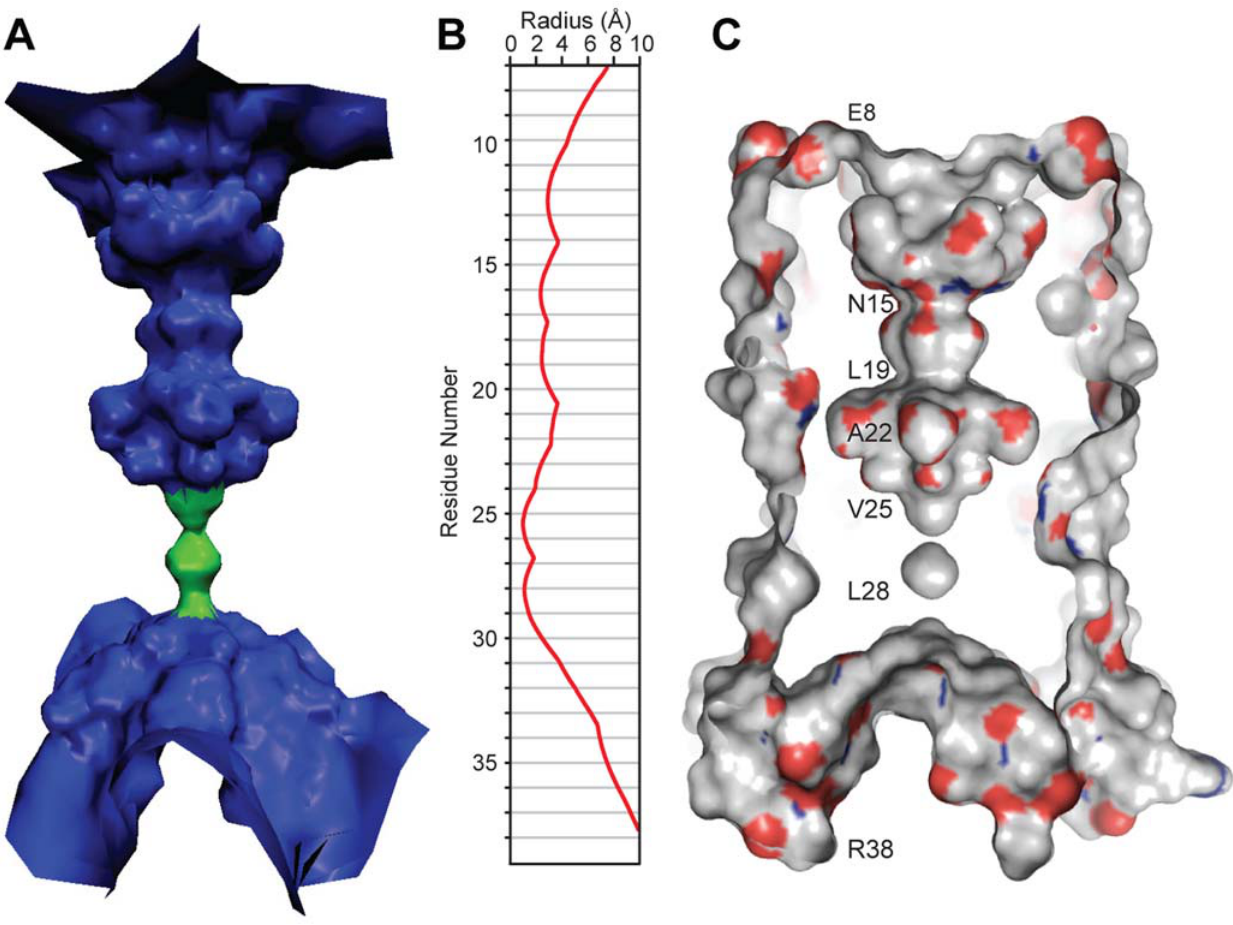
Figure 4. Pentameric structure of ETM. (A) Lumen of the a -helical bundle (blue) formed by the ETM a -helices (omitted for clarity), with most constricted region at V25 (green). (B) Radius of the lumen of the ETM channel as a function of residue number, calculated by HOLE [66]. (C) Side view surface representation of the ETM channel showing the lumen volume. Oxygen and nitrogen atoms are colored red and blue respectively.